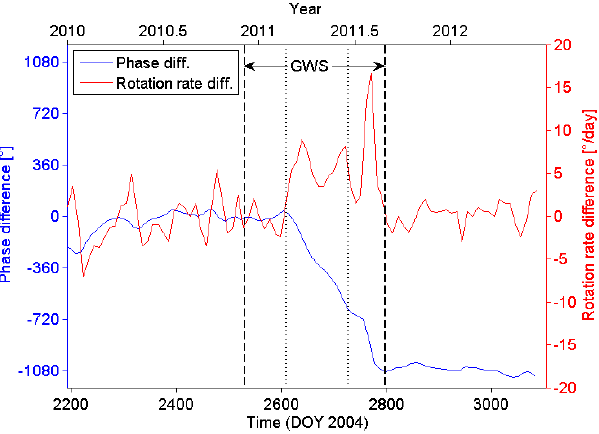
Figure 6. Rotation rates/periods of northern and southern SKR over 2.5 years from the beginning of 2010 until the middle of 2012. The SKR rates have been derived by following the SKR phases (Fischer et al., 2014). They are displayed as solid lines in blue and red color for northern and southern SKR, respectively. The lower horizontal axis denotes the time in days of year 2004, and the upper horizon- tal axis denotes the years. The left vertical axis shows the rotation rate in degrees per day, whereas on the right one can see the rota- tion period in hours. The horizontal dotted black line indicates the constant guide period of 10.6567h (810.7576 ◦ day − 1 ). The black dashed lines indicate the start and end of the GWS event (5 Decem- ber 2010 until 28 August 2011), respectively.